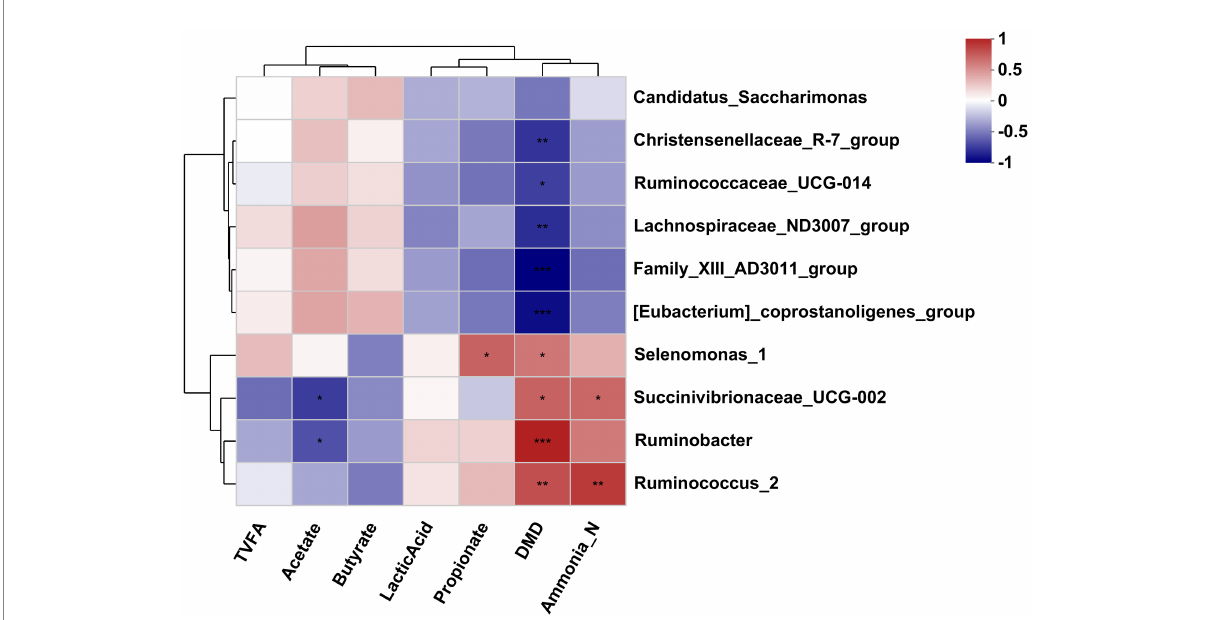
FIGURE 5 Correlation analysis between differential bacteria genus and differential fermentation parameters in the rumen fluid of dairy cows after 48 h in vitro fermentation with two glucogenic and a lipogenic diet. Each row represents a bacteria genus, only the genera with a relative abundance >0.5% are selected; each column represents a fermentation parameter. The color blue means negative correlation, and the color red means positive correlation. *0.01 < p ≤ 0.05, **0.001 < p ≤ 0.01, *** p ≤ 0.001.